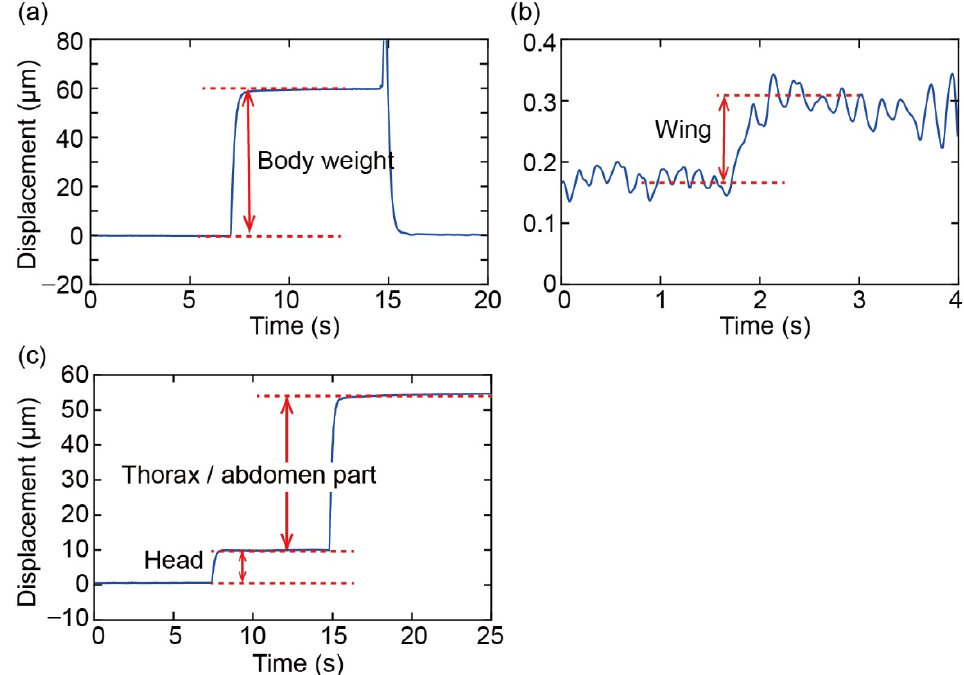
Figure 13. Displacement output of measuring ( a ) body mass, ( b ) wing mass, and ( c ) head and thorax/abdomen mass of a fruit fly.